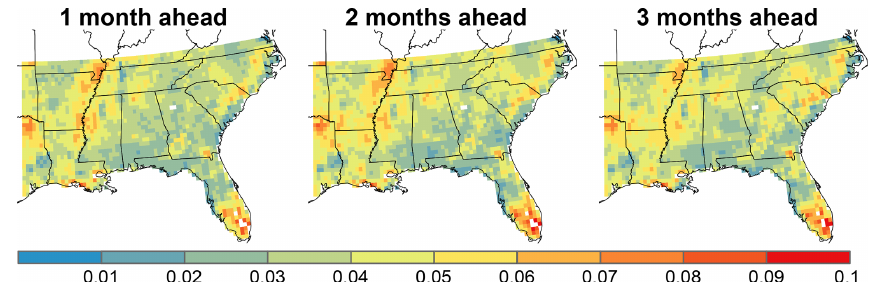
Figure 2. RMSE of the bias corrected 1- to 3-month-ahead soil moisture forecasts based on the SMAP soil moisture observations.